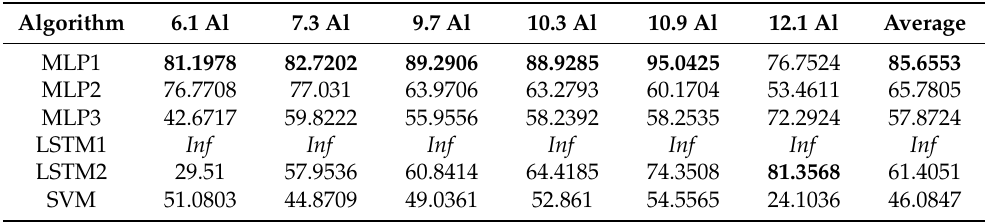
Table 6. Accuracy achieved in predicting the complete curve of Exp. 4 using the Kolmogorov– Smirnov goodness-of-fit test. It is observed that the mono-layer MLP network is the one that obtains the best